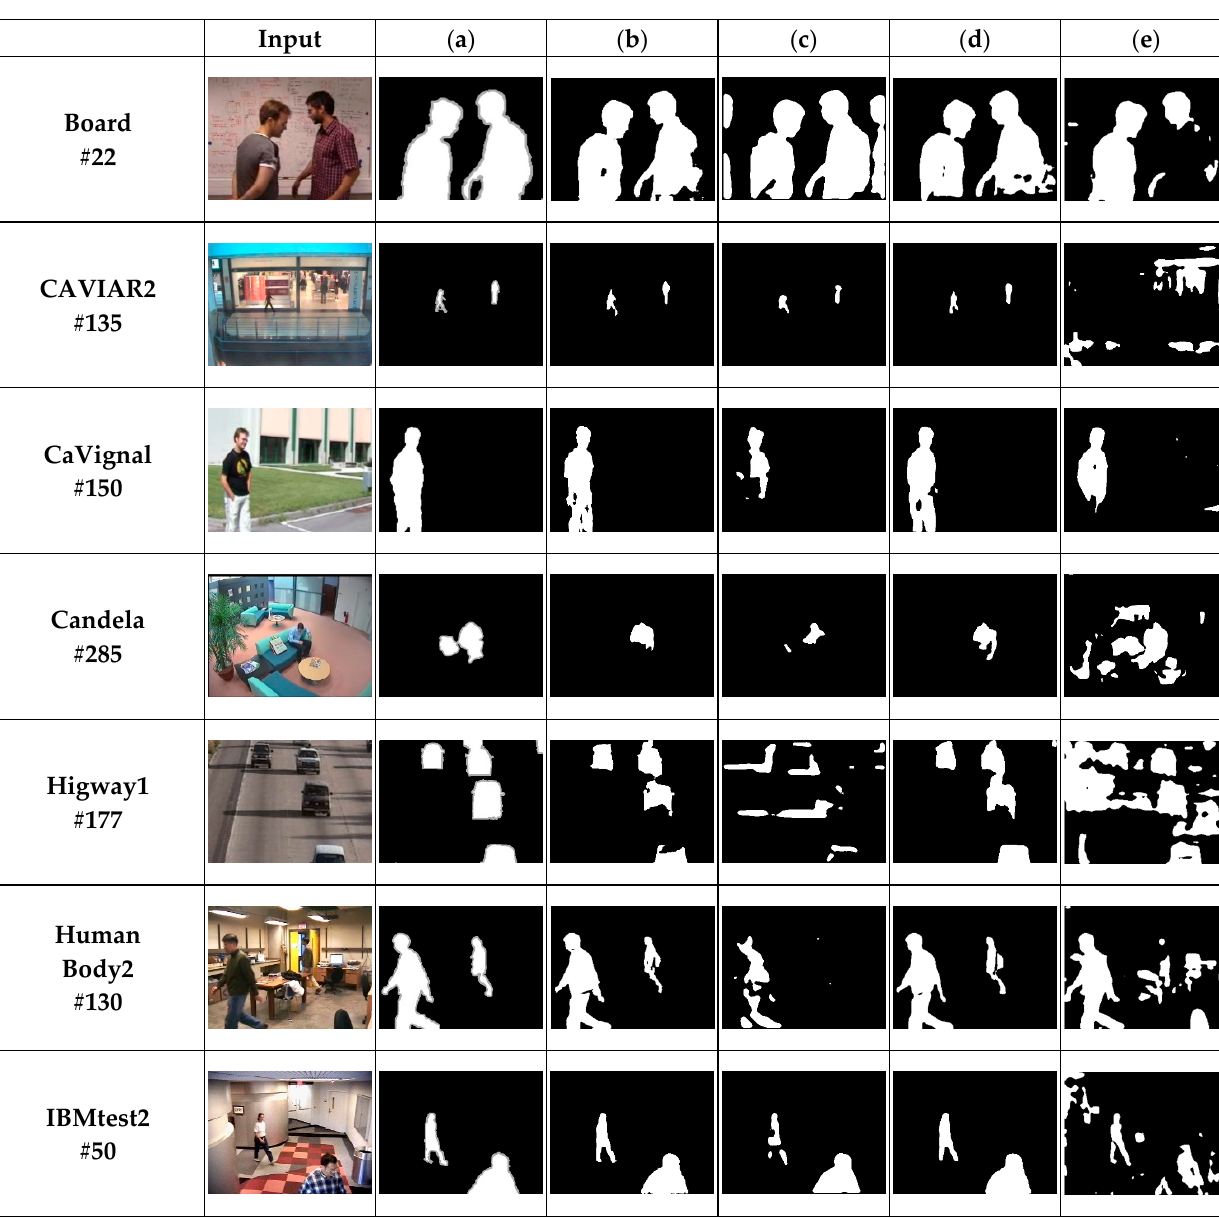
Figure 6. Test results on SBI2015 dataset: ( a ) ground truth foreground maps, ( b ) proposed method, ( c ) SuBSENSE [2], ( d ) modified FgSegNet-v2, ( e ) FgSegNet-v2 [42].